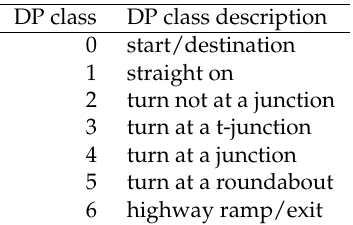
Table 2: Types of street segments ( T ).